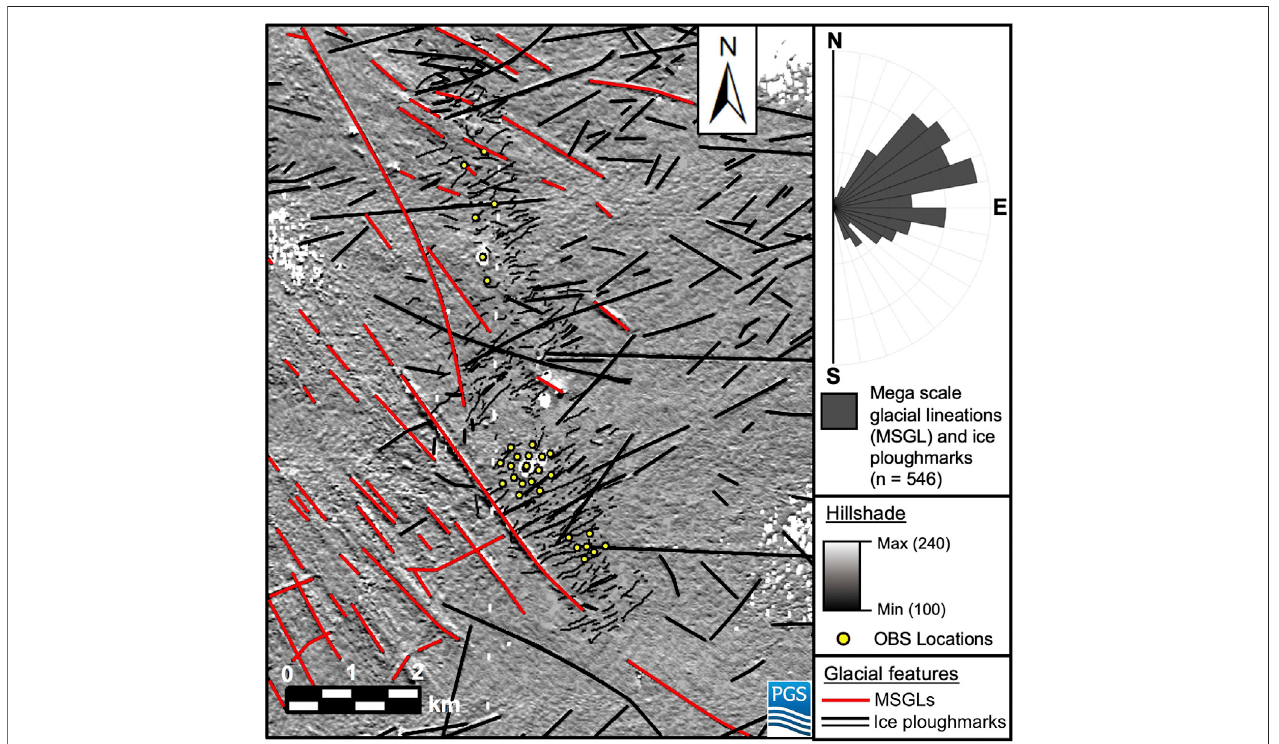
FIGURE 10 | Plan view of glacial features mapped onto seismic unit top S4 (see also Supplementary Figures S2, S3 ). The map shows a seismic amplitude contrast (hillshade) image of unit top S4 (base of the Witch Ground Formation). Black lines display mapped ice ploughmarks and red lines display mega-scale glacial lineations (MSGLs), interpreted using the 2D and 3D seismic re fl ection data. A length-weighted histogram displays the most common orientation of the glacial features across the Scanner Pockmark region, binned into 10 ° intervals.